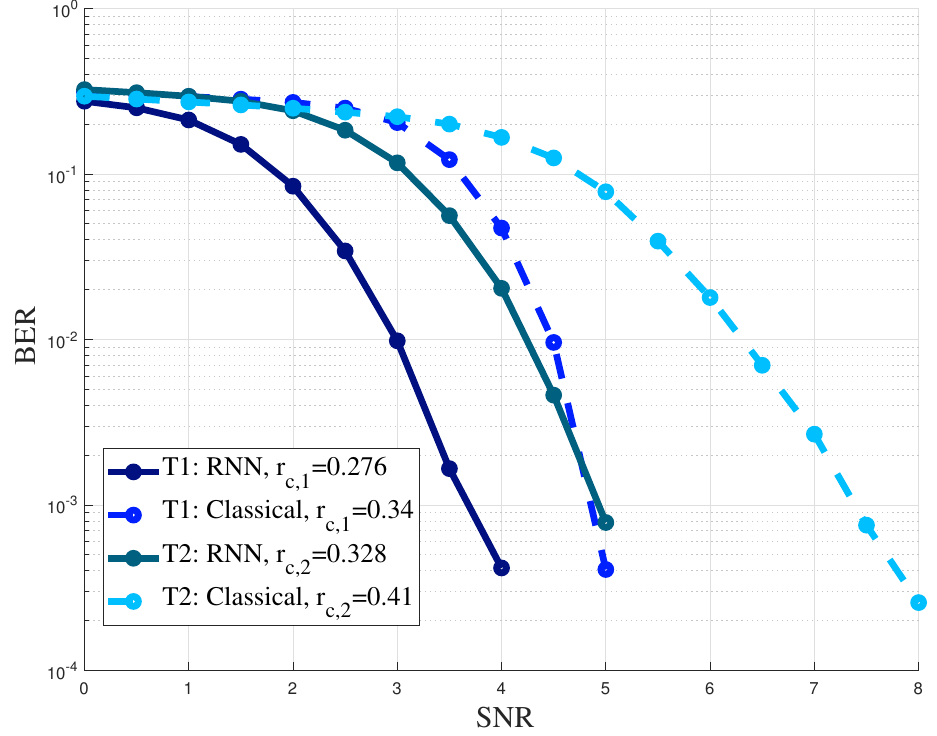
Figure 5. The end-to-end simulation for different throughput systems (T1 = 93 kbit/s) and (T2 = 110 kbit/s) at a fixed speed of 120 km/h and a large ISD (125 km ISD). The RNN with 5GNR numerology and trained at 3 km/h and the classical system with a 0.37 kHz carrier spacing with a long cyclic prefix of 300 µ